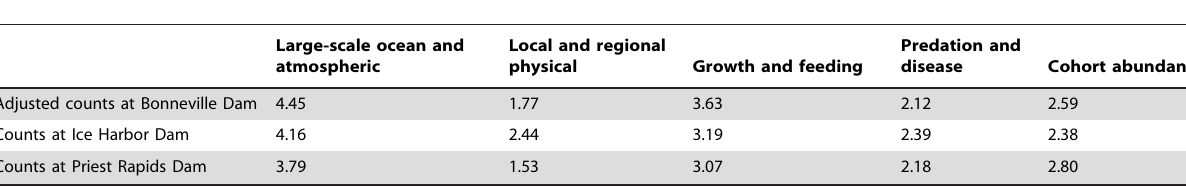
Values represent the average weight of all indicators within a category.